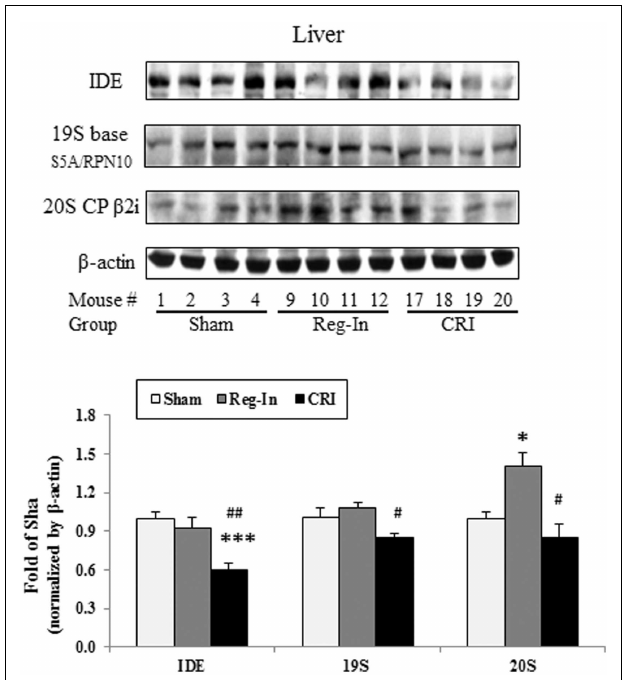
FIGURE 4 | Insulin-degrading enzyme, 19S and 20S proteasome protein abundance was analyzed in the liver of KKAy mice . Detail was described in the Section “Materials and Methods.” Results were normalized by β -actin. Data were presented as mean ± SEM ( n = 8/group). * P < 0.05 and *** P < 0.001, CRI or Reg-In group vs. Sham group, respectively. # P < 0.05 and ## P < 0.01, CRI vs. Reg-In, respectively.